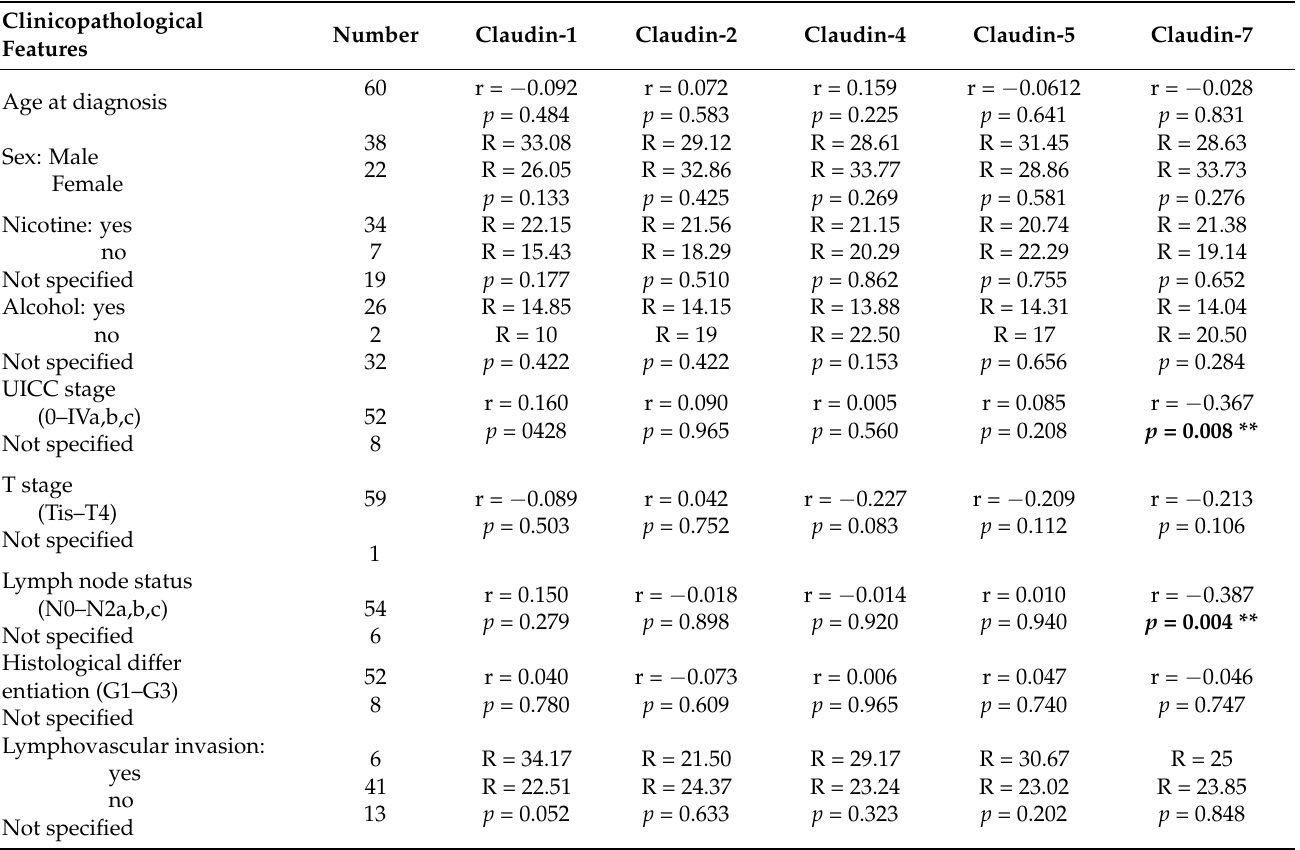
Table 2. Claudin expression in the OSCC and clinicopathological